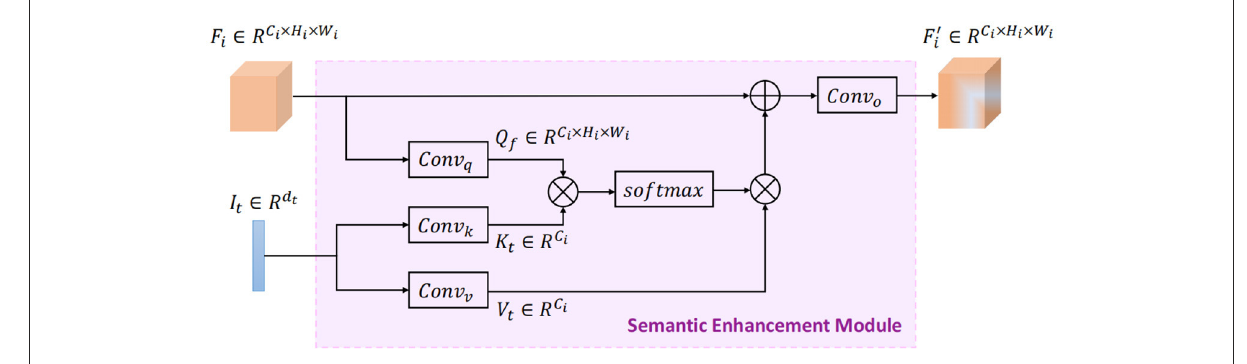
FIGURE2 The semantic enhancement module (SEM) in audio/visual